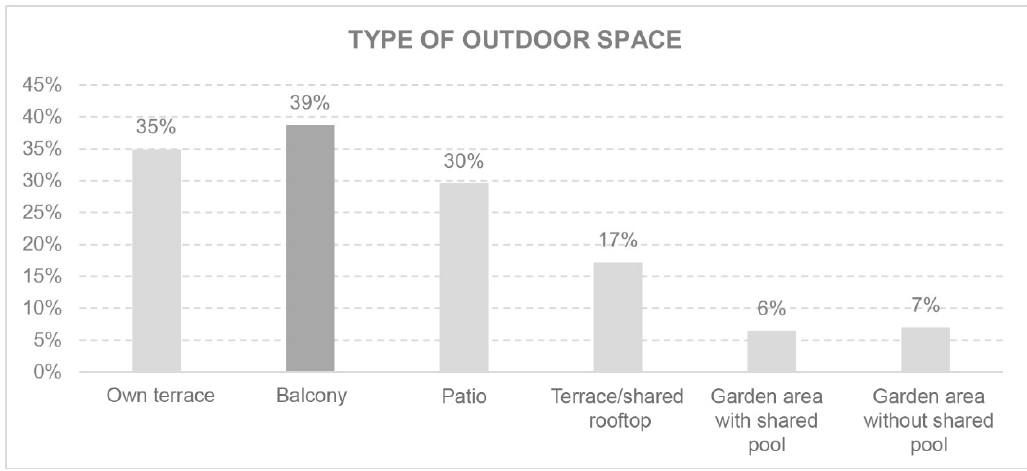
Figure 9. Feeling produced when looking through a window.